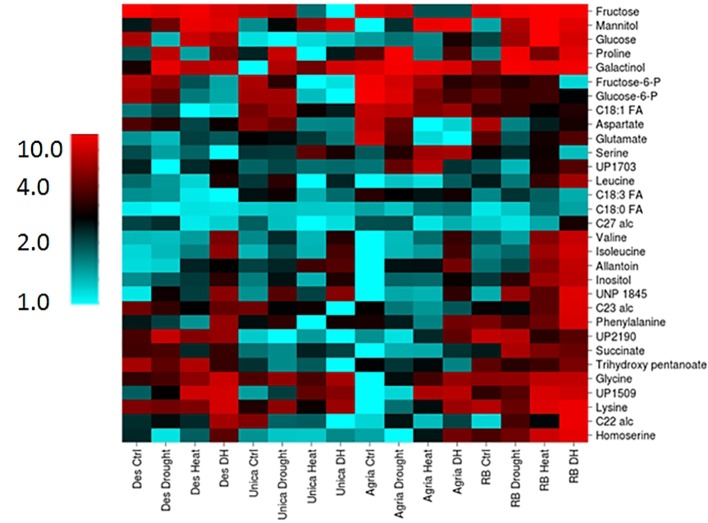
Heatmap of leaf metabolites exhibiting a genotype x treatment interactive effect on concentration. Columns labels indicate genotype and treatment. Metabolites were clustered using the CIMminer tool ((https://discover.nci.nih.gov/cimminer/home.do, Weinstein et al., 1994) following normalization by calculating the mean abundance of each metabolite from three independent biological replicates relative to the sample in which each metabolite had the lowest mean concentration.